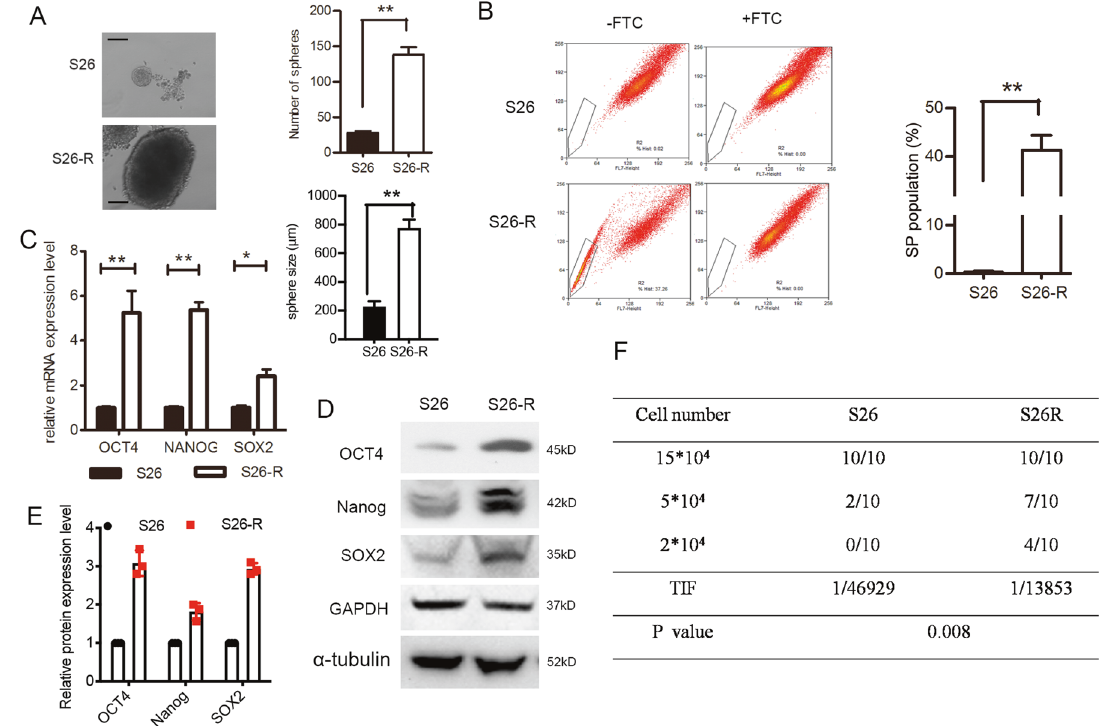
Fig. 2 Ionizing radiation enhanced CSC subpopulation enrichment and radioresistance in vitro and in vivo. A Single-cell suspensions were seeded in ultra-low-attachment culture plates. The formed spheroids were counted via microscopy. Representative images are shown, the number (upper) and the size (lower) of S26 and S26-R cells were compared, ** p < 0.01, Student ’ s t -test, Scale bar: 200 μ m. B Percentages of SP cells are shown in the left panel; three independent experiments were performed; The right panels show the upregulation of SP in cells S26-R NPC cells, ** p < 0.01, Student ’ s t -test. C (Left) mRNA levels of stem-cell markers were determined by quantitative PCR analysis, ACTB (encoding β -actin) was used as a control. (Right) protein levels of stem-cell markers as determined using western blotting; β -actin was used as the loading control. D A total of 2 × 10 4 , 5 × 10 4 , and 15 × 10 4 of S26 and its radio-resistant S26-R NPC cells were subcutaneously injected into NOD/SCID mice ( n = 10 mice/group). A summary of tumorigenicity in mice is shown. The TIF and p -value were calculated by using ELDA software. (NPC, nasopharyngeal carcinoma; CSC, cancer stem cell; SP, side population; NOD, non-obese diabetic; SCID, severe combined immunode fi ciency; TIF, tumor-initiating cell frequency; ELDA, extreme limiting dilution analysis). was activated in S26-R cells. The AKT inhibitor MK2206 ef fi ciently contributed to radioresistance (Fig. 4D) and decreased nuclear blocked the activation of AKT, as detected by a decrease in AKT condensation (Fig. 4E and Fig. S5B) upon exposure to radiation. and its downstream ribosomal S6 kinase or 4EBP1 phosphoryla- tion, which consequently caused downregulation of MCL-1 Activation of the ROS-AKT feedback loop regulates the protein expression (Fig. 5C). protein synthesis of MCL-1 in vitro High levels of ROS are the main driver for cell death induced by Regulation of MCL-1 expression occurs at the transcriptional, irradiation. However, persistent ROS could be a key step in the translational, and posttranslational levels. We measured the mRNA transformation of cancer cells to CSCs [39, 40]. To determine the levels of MCL1 using quantitative PCR and found that the mRNA effects of ROS generation between IR-treated and untreated NPC level was not altered in radioresistant S26 and SUNE1 NPC cells cells, we performed an DCFH-DA assay. We observed an obvious (Fig. S6A). We treated cells with CHX, a translation inhibitor, and increase in ROS soon after radiation and a quick decrease after 8 h, collected protein at indicated time points to test existing MCL-1 and then a slow decrease to the basal level over 1 to 2 weeks in protein levels. The results showed that MCL-1 protein stability was S26 cells (Fig. S7A). S26-R cells have higher basal level of ROS increased slightly in S26-R cells when compared with that in S26 without treatment when compared with S26 (fold- change = cells (Fig. 5A). Then, the MCL-1 synthesis level was compared 1.95 ± 0.25, Fig. S7B). However, S26-R cells displayed relatively between S26 and S26-R cells treated with cycloheximide to lower level of ROS generation in the fi rst day after IR treatment remove MCL-1 proteins and then treated with MG132 to obtain (fold-change = 0.86 ± 0.05 in 0 h; fold-change = 0.68 ± 0.11 in 8 h, newly synthesized proteins. Radioresistant S26-R cells exhibited Fig. S7B), but a signi fi cant increase after 2 days(fold-change = increased synthesis of the MCL-1 protein (Fig. 5B). 3.45 ± 0.36, Fig. S7B) through to 1 week when compared with S26 The process of protein synthesis is active during mitosis. DNA cells, suggesting a persistently higher basal level of ROS in the content analysis by fl uorescence microscopy con fi rmed that S26-R process of CSC formation (Fig. S7B). AKT inhibitor treatment cause cells had arrested at the G2/M phase, and showed polyploid a slight decrease in HIF-1 α levels (a direct target of ROS) and multinucleate cell formation (Fig. S6B), suggesting that S26-R cells signi fi cant downregulation of intracellular ROS levels (Fig. 5C, D). had advantage for protein synthesis. The AKT-mechanistic target Then, N-acetylcysteine (NAC) was applied to inhibit basal ROS of rapamycin (mTOR) signaling pathway has been reported to be levels, and the ef fi ciency of NAC was con fi rmed by reduced ROS involved in the protein synthesis process [37, 38]. To further and HIF-1 α levels. Downregulation of AKT and phosphorylation of investigate the mechanism of increased synthesis of MCL-1 in IR- its downstream ribosomal S6 kinase were consistently observed induced NPC cells, we tested the AKT pathway signal and found it